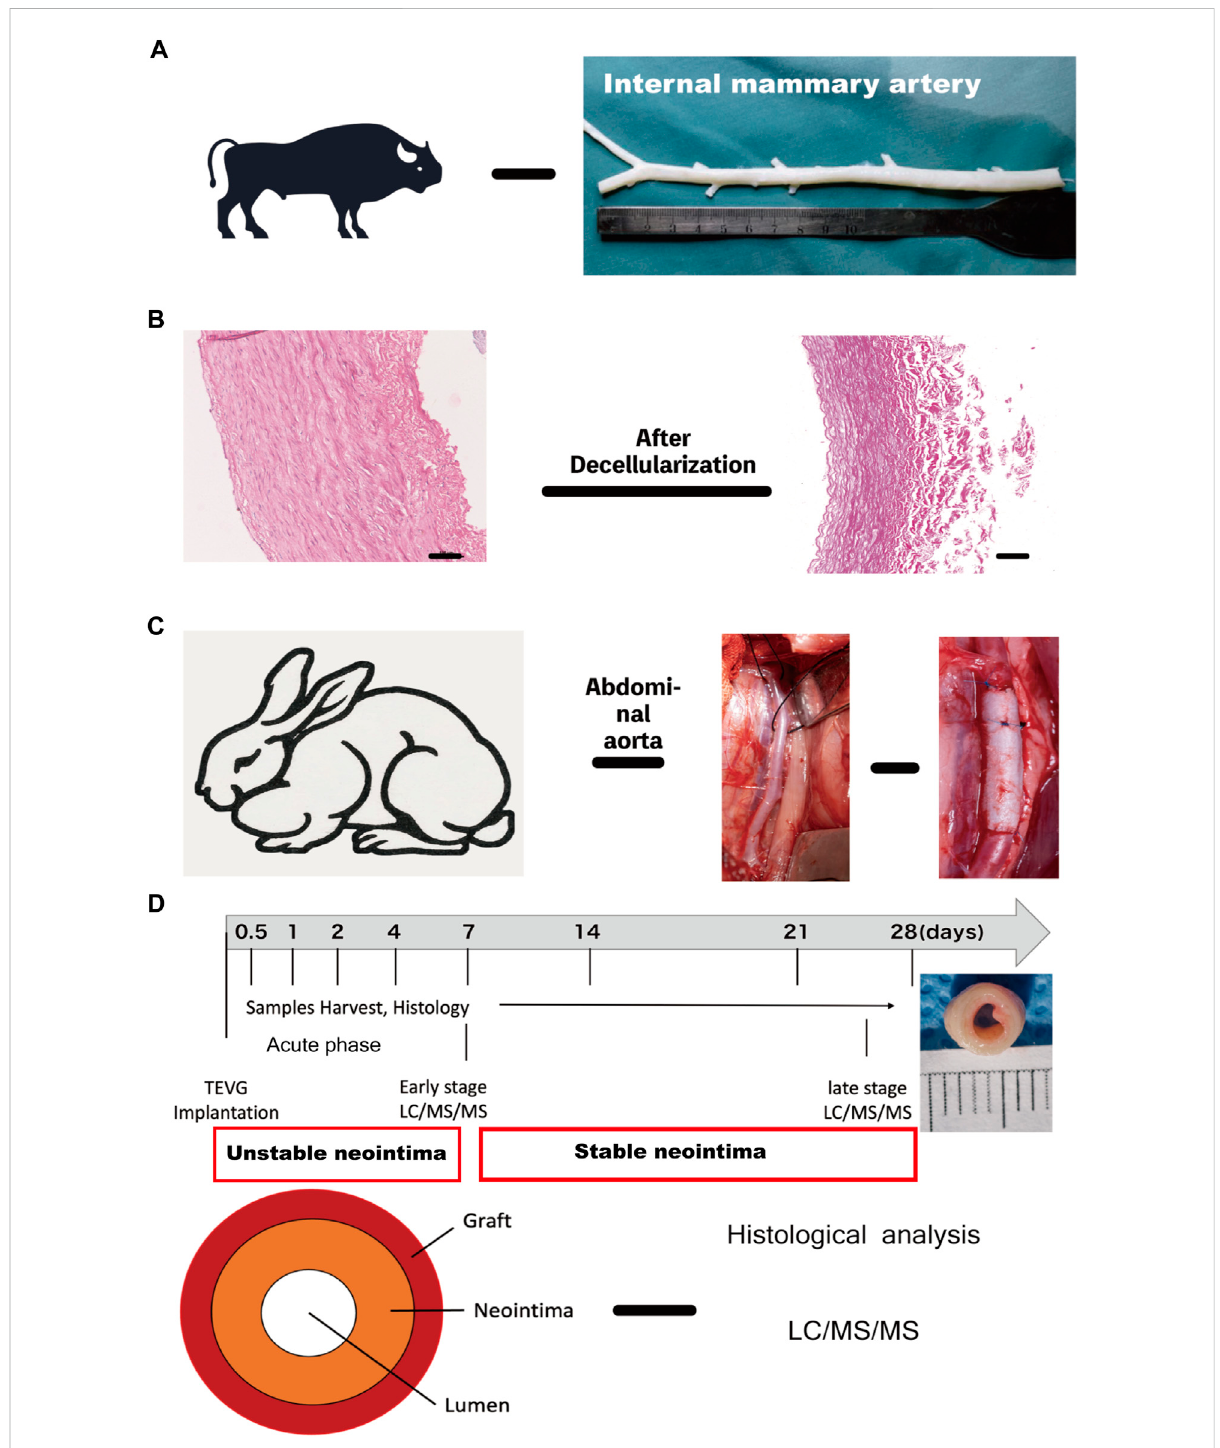
FIGURE 1 Experimental design and work fl ow for the proteomic and histological analysis (A) Internal mammary artery (B) H&E images of Native internal mammary artery and decellularized artery, scale bar = 100 μ m. (C) Intraoperative image of TEVG implantation in the rabbit abdominal aorta. (D) Schematic overview of study design and neointima structure: grafts were implanted and harvested at 0.5, 1, 2, 4, 7, 14, 21 and 28 days for histological and proteomic analysis. (I: acute phase-unstable neointima: 0.5 – 4 days; II&III: early (1 week) and late-stage phase (3 – 4 weeks))TEVG, tissue-engineered vascular graft. TEVG: Tissue-engineered vascular graft; H&E: Haematoxylin and eosin